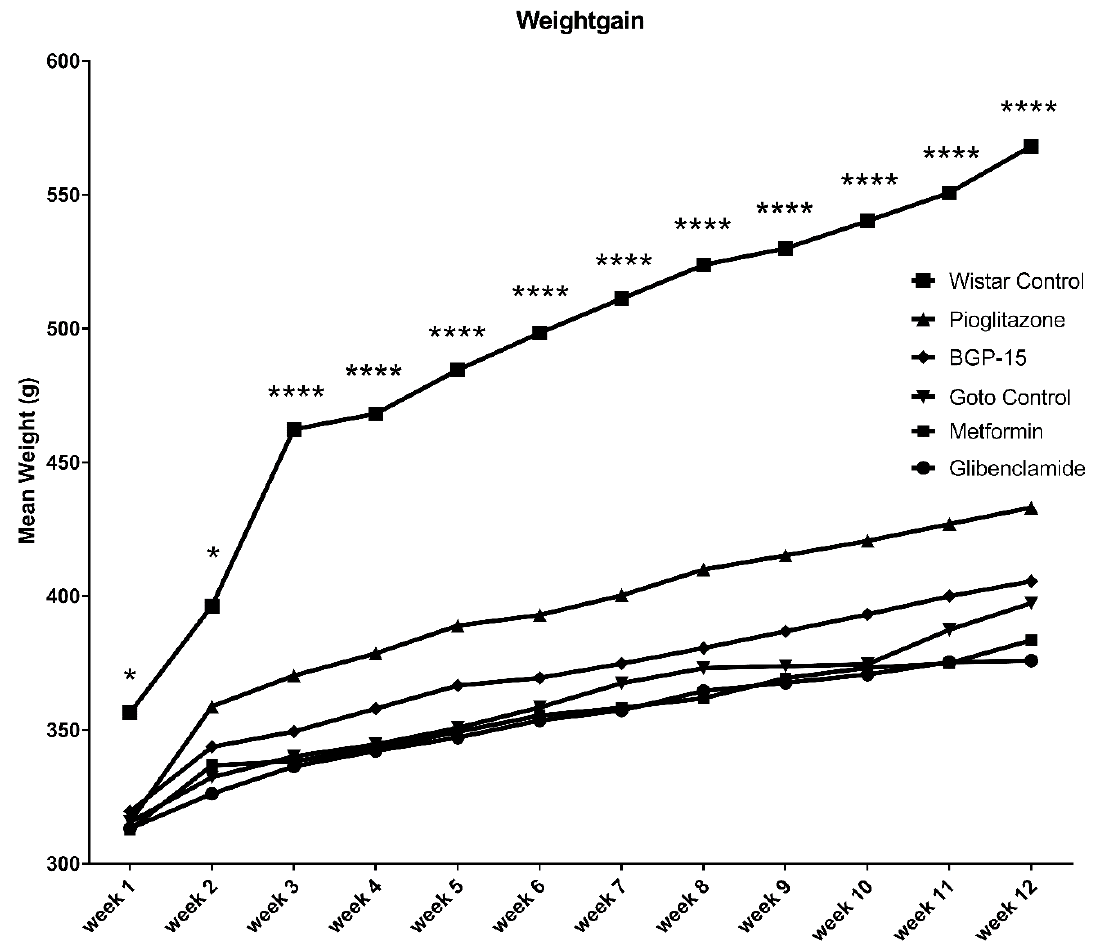
Figure 2. Weight gain of animal groups during the 12 weeks of the experiment. Data is presented as group mean. For a better visibility, standard error of the mean (SEM) of each data points are not plotted. n=6 animals in each group. * p < 0.05 compared to all other groups; **** p < 0.0001 compared to all other groups. Statistical analysis was done using GraphPad Prism: data was analysed with two-way analysis of variance (ANOVA) test.